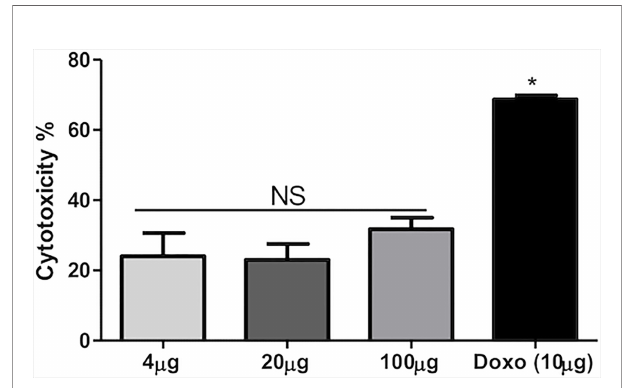
FIGURE 3 | Percentage cytotoxicity vs. concentration of extract. NS = Non signi fi cant; * = Signi